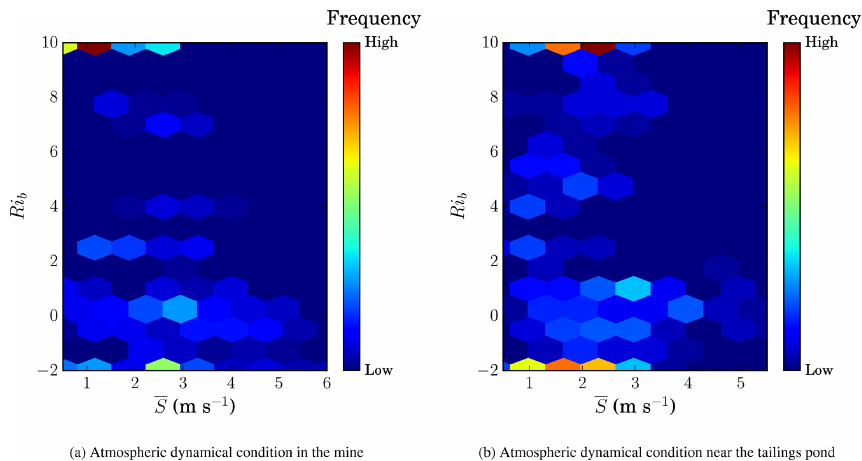
Figure 14. Frequency plots of atmospheric dynamical condition as a function of bulk Richardson number Ri b and mean wind speed S in the mine (a) and near the tailings pond (b)